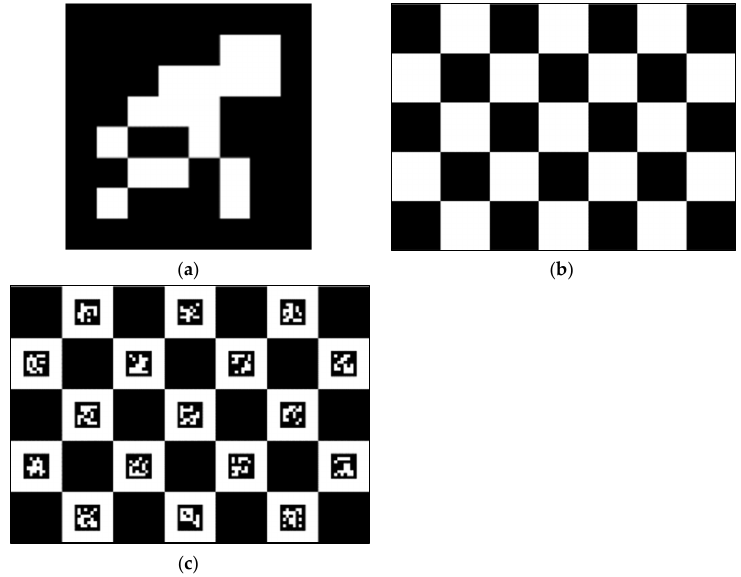
Figure 2. ( a ) ArUco marker; ( b ) Checkerboard; and ( c ) ChArUco board.